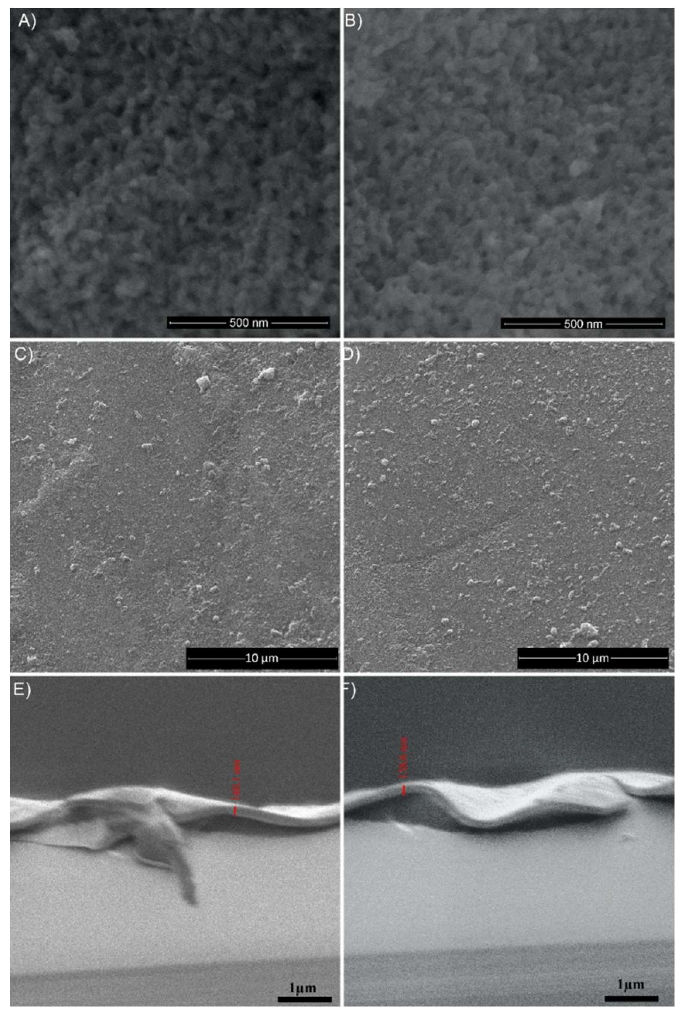
Figure 6. SEM images of the ZnHAp-500 ( A , C ) and ZnHAp-700 ( B , D ) layers at different magnifications. SEM images of the transversal cross section of ZnHAp-500 ( E ) and ZnHAp-700 ( F ) layers.